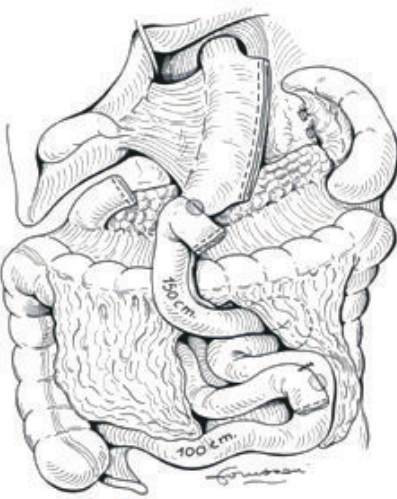
Figure 3: Biliopancreatic diversion with duodenal